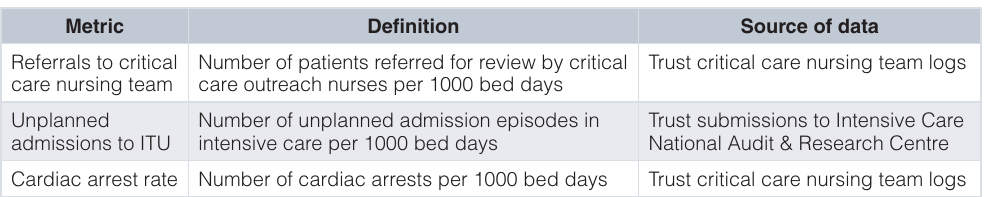
Table 3. Definitions and data sources for Trust-wide outcome metrics.